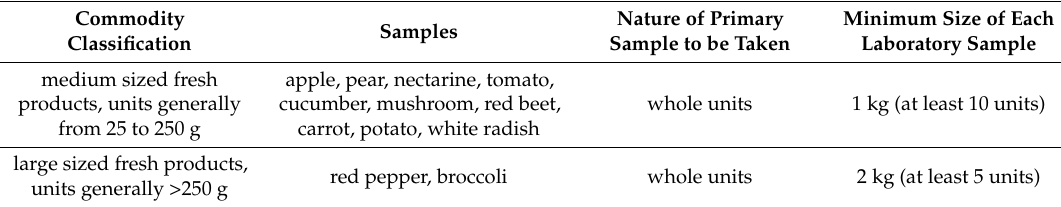
Table 4. Description of primary samples and minimum size of laboratory